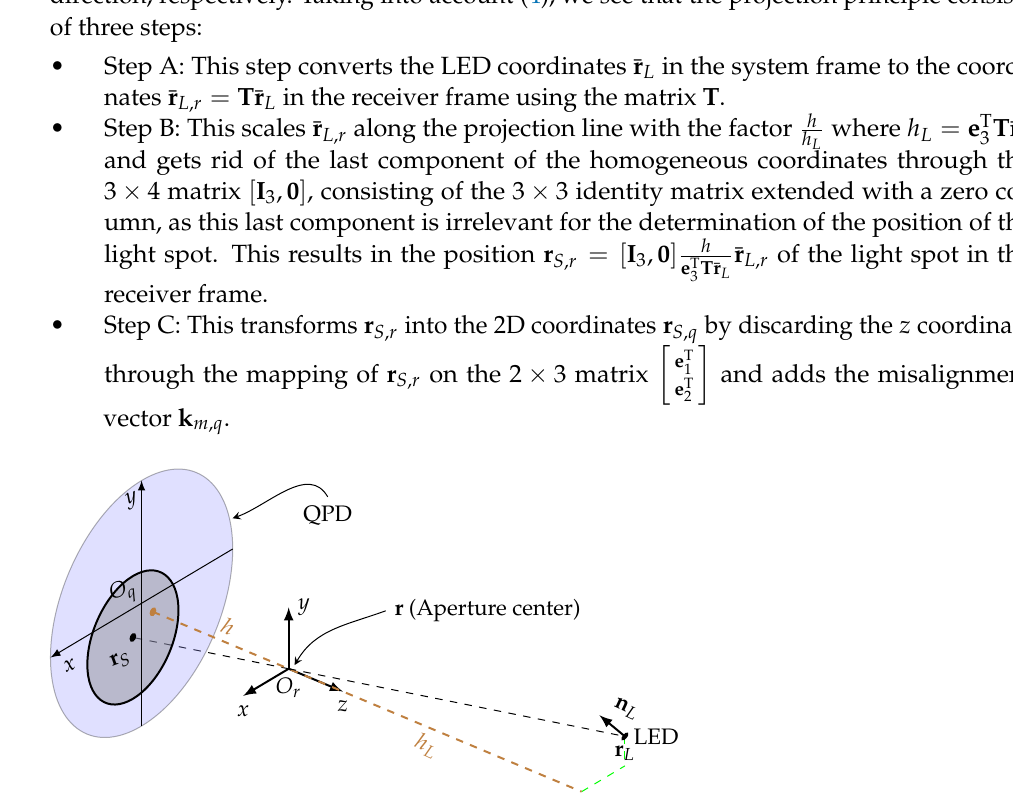
Figure 3. The channel link model. The position of the LED and centers of the aperture and the light spot comply with the perspective projection model, while the shape and size of the light spot is determined by the aperture. Note that in this perspective projection model, the light spot does not correspond to the image of the LED, but it only relates the position of the light spot with the position of the